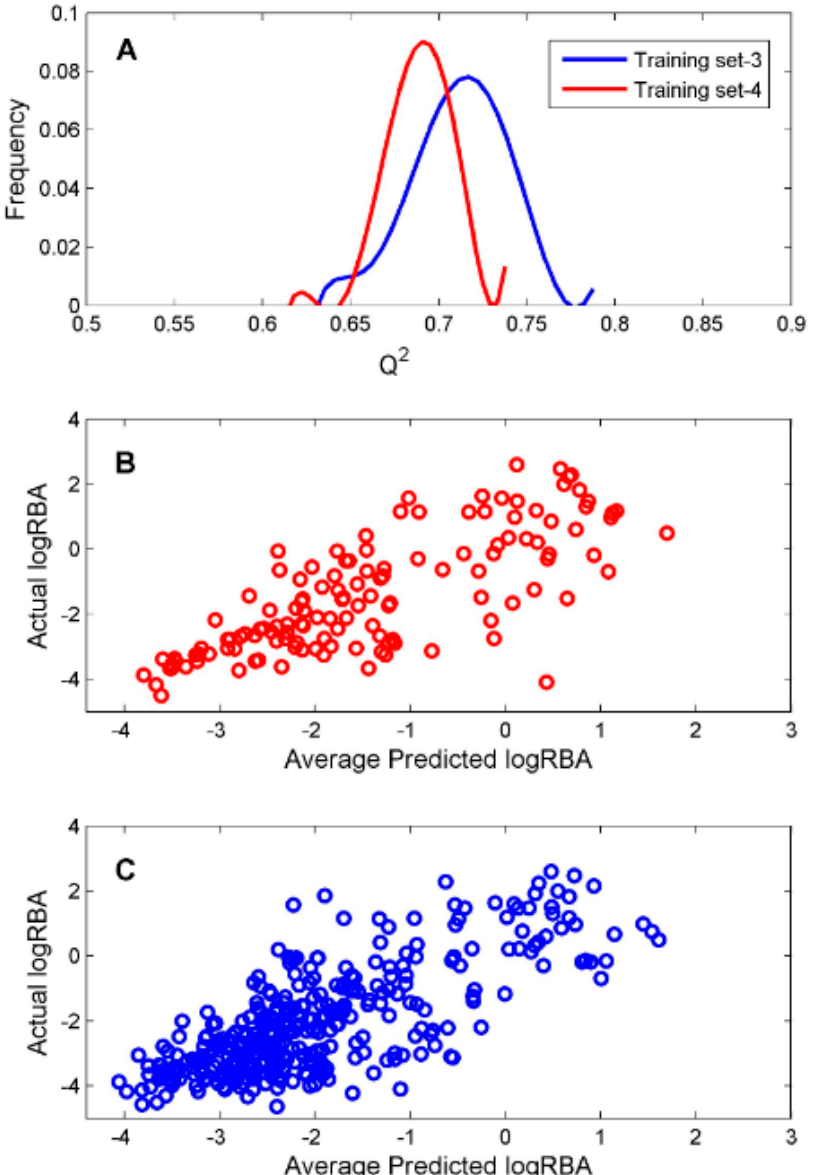
Figure 5. Regression performance of the 5-fold cross validations. The distributions of Q 2 values were plotted as blue and red lines for TS-3 and TS-4 ( A ). The average predicted logRBA of the 1000 iterations of 5-fold cross validations were plotted against the actual logRBA for TS-3 ( B ) and TS-4 ( C ). The mean and standard deviation of the Q 2 values were 0.712 and 0.027 for TS-3 and 0.690 and 0.018